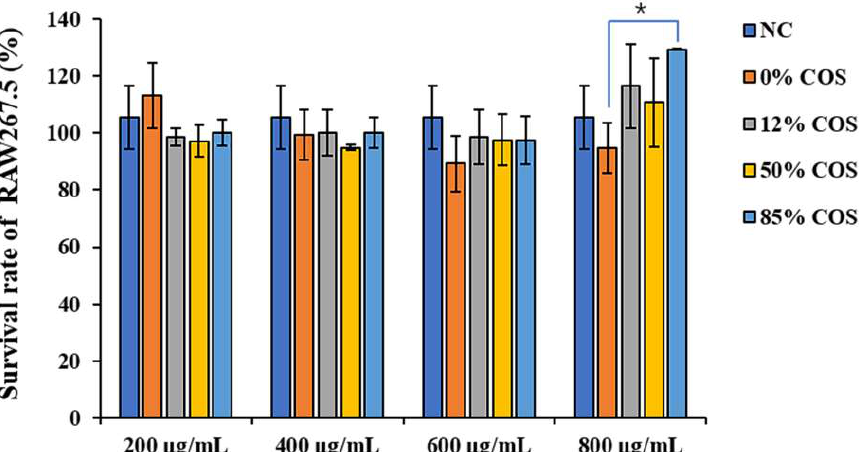
Figure 3. Effects of different concentrations of COSs on macrophage cell viability. At the concentrations used in this study, these COSs had no cytotoxic effects on cells. The data are presented as means ± SD of three replicates. * There is a significant difference between 0% COS with 85% COS in 800 μg/mL, p ≤ 0.05.